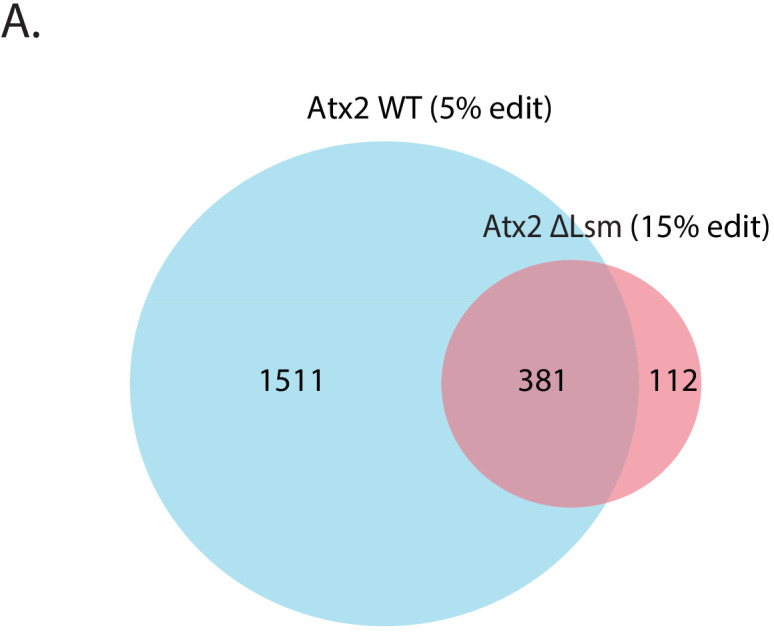
Atx2∆Lsm unique targets were present at a reduced edit threshold in Atx2 WT.Several of the Atx2∆Lsm edits found at 15% threshold were found in Atx2 WT edits at 5% threshold.